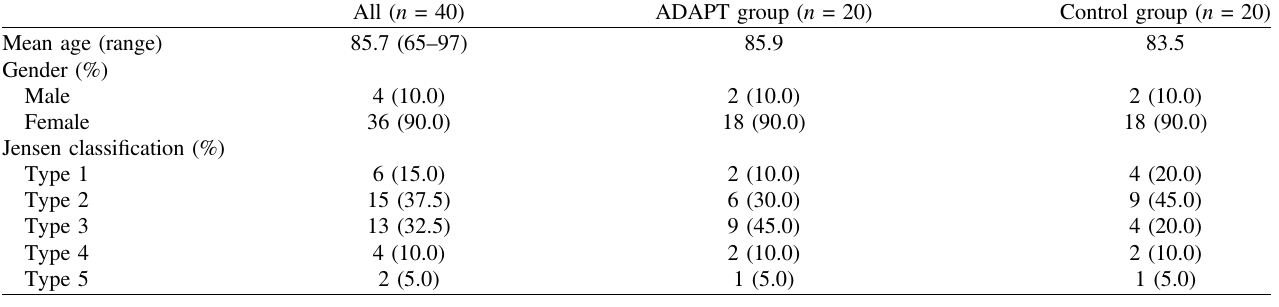
Table 1. Patient background. Percentages and ranges are shown for categorical and continuous data, respectively, in brackets. All ( n = 40)